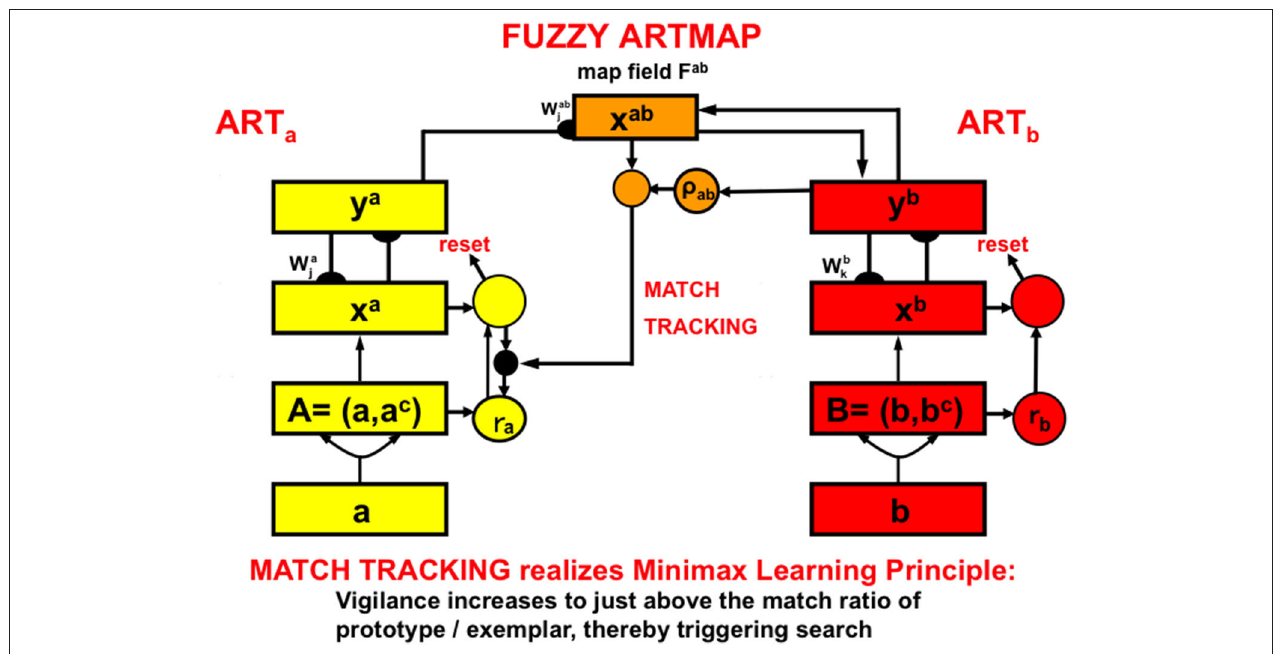
FIGURE 8 | The fuzzy ARTMAP architecture can learn recognition categories in both ART a and ART b by unsupervised learning, as well as an associative map via the map field from ART a to ART b by supervised learning. See the text for details [adapted with permission from Carpenter et al. (1992)].